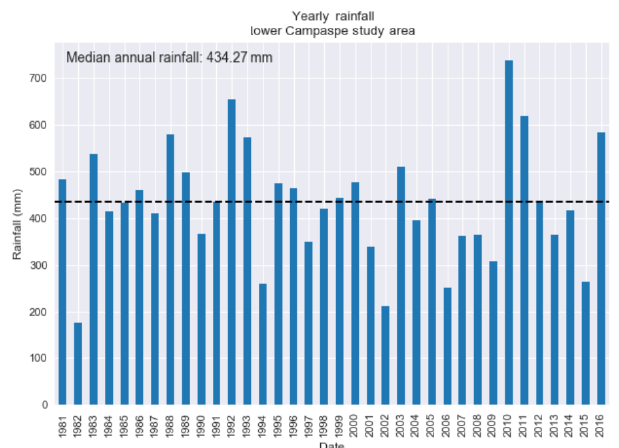
Figure 2. Yearly rainfall in the Lower Campaspe study area. The median amount was found to be 434mmyr − 1 (indicated by the dashed black